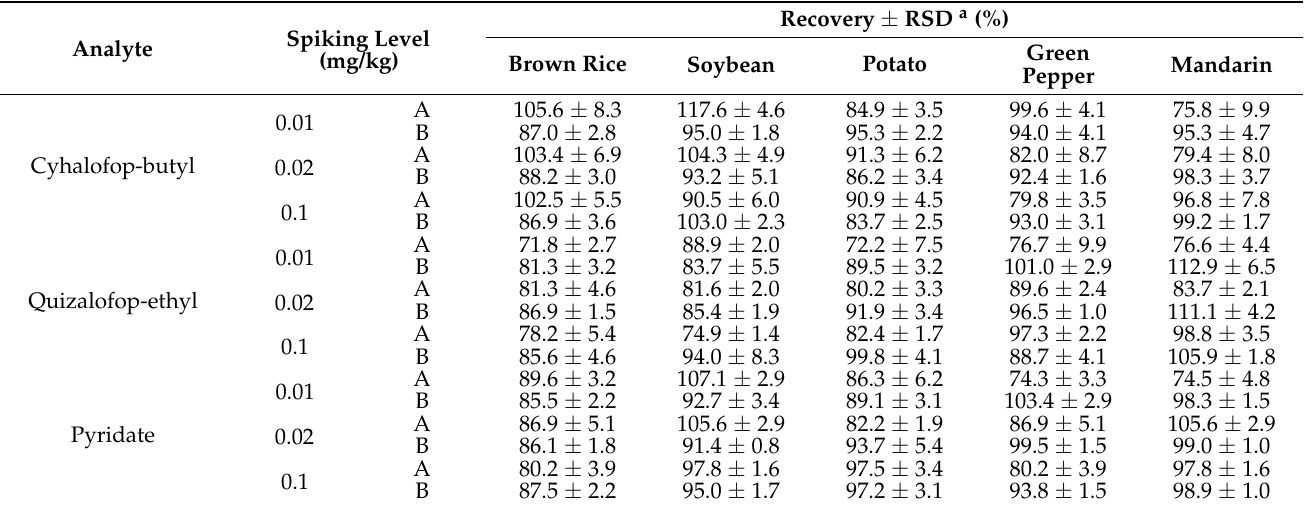
Table 7. Inter-lab A and B validation results of the proposed analytical method for the determination of three residual herbicides in food